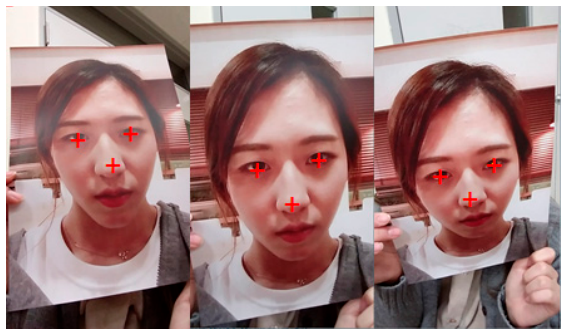
Figure 6. Results for MTCNN using fake face data from a printed photo attack.